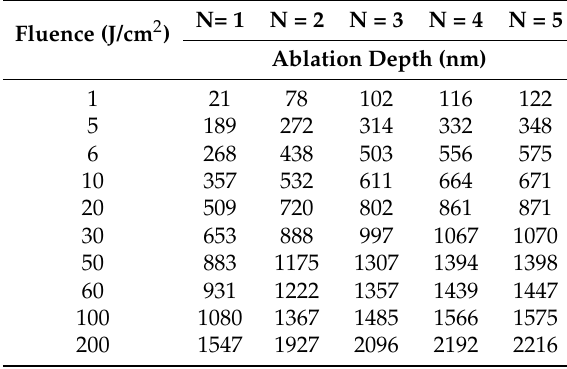
Table 1. Ablation depth calculated by varying the fluence at different